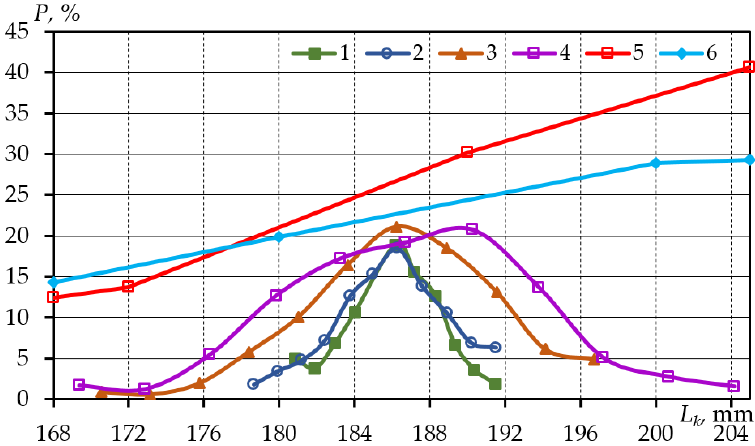
Figure 8. Tire contact length distribution for different road quality and tire models: 1 — smooth asphalt pavement 2D; 2 — smooth asphalt pavement 3D; 3 — low quality asphalt pavement 2D; 4 — low quality asphalt pavement 3D; 5 — gravel road 2D; 6 — gravel road 3D.